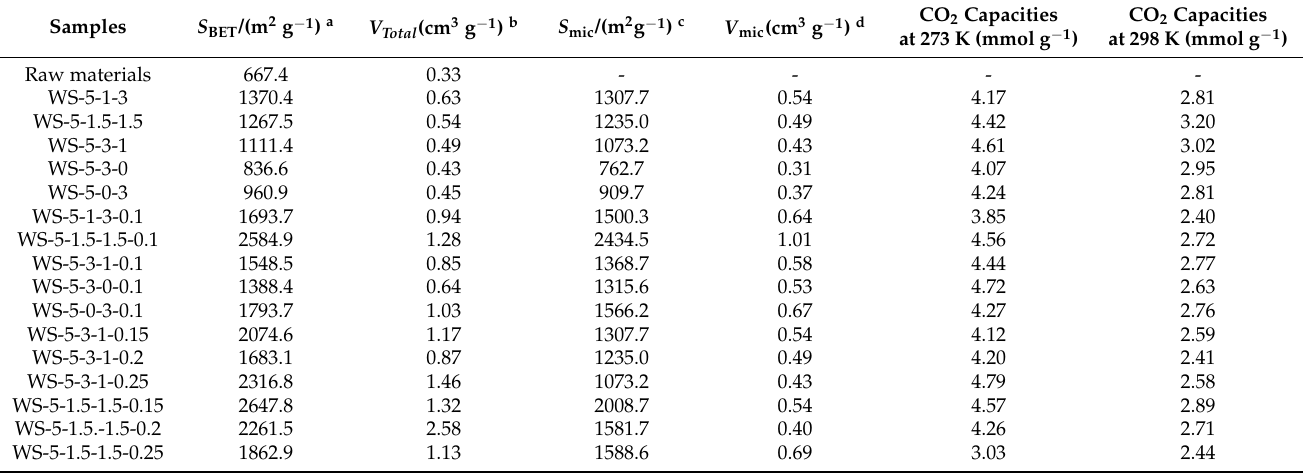
Table 2. The effect of the activation ratio of biomass, metal salts and H 2 O(g) on the surface properties of biochar, and CO 2 adsorption capacities of adsorbents at different